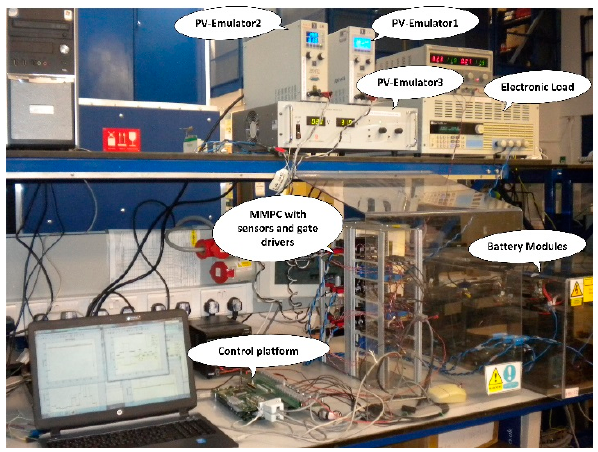
Figure 10. Experimental setup for testing of the proposed modular multiport converter.